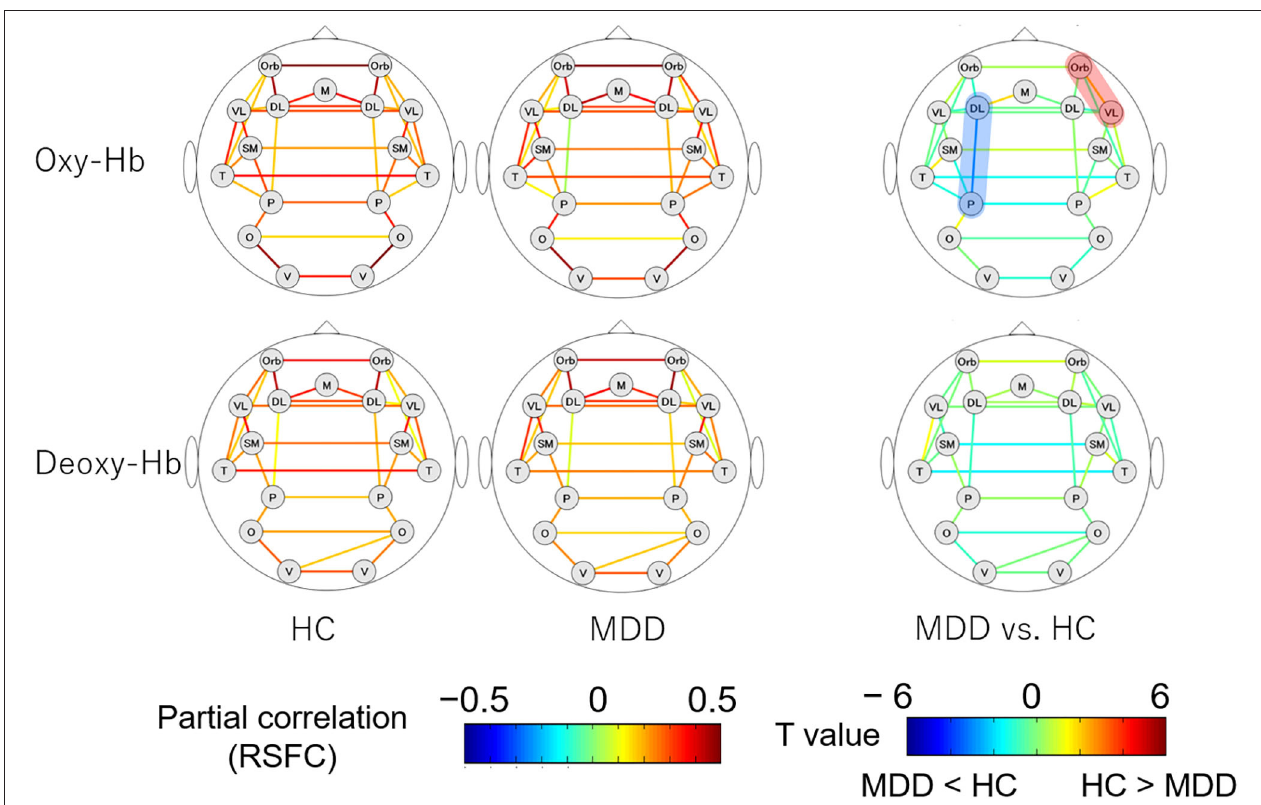
FIGURE 2 | RSFC patterns of the MDD and HC groups. The upper and lower rows show the RSFC patterns calculated from oxy- and deoxy-Hb signals, respectively. The figures on the left illustrate the RSFC patterns of the HC group and the figures in the middle illustrate the RSFC patterns of the MDD group. The figures on the right show the comparison of the strengths of RSFCs between the MDD and HC groups. The brain region pairs, where the strength of RSFC was significantly different between the groups are highlighted in red (MDD > HC) or blue (HC > MDD). MDD, major depressive disorder; RSFC, resting-state functional connectivity; HC, healthy control; oxy-Hb, oxygenated hemoglobin; deoxy-Hb, deoxygenated hemoglobin; DL, dorsolateral prefrontal cortex; M, medial prefrontal cortex; Orb, orbitofrontal cortex; VL, ventrolateral prefrontal cortex; SM, sensorimotor area; P, parietal lobe; T, temporal lobe; O, occipital lobe; V, visual